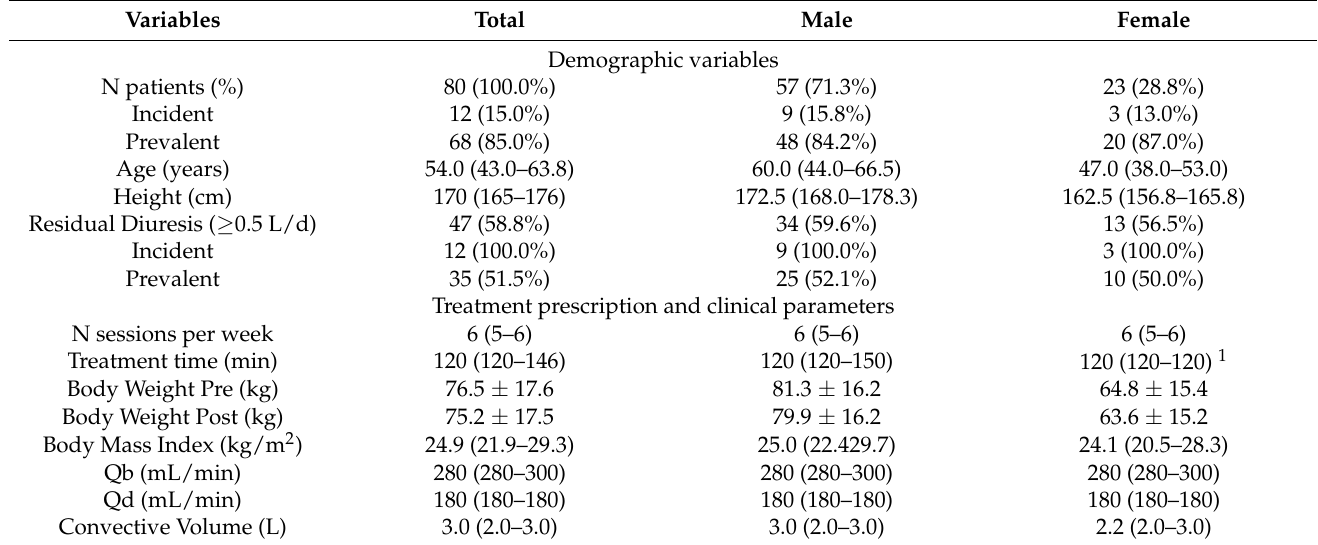
Table 1. Characteristics of the study population at baseline. Values were described by us- ing proportions for categorical variables and mean values ± standard deviation or median (percentile 25–percentile 75) for quantitative variables according to their distribution in the total population. (Pre, Predialysis; Post,